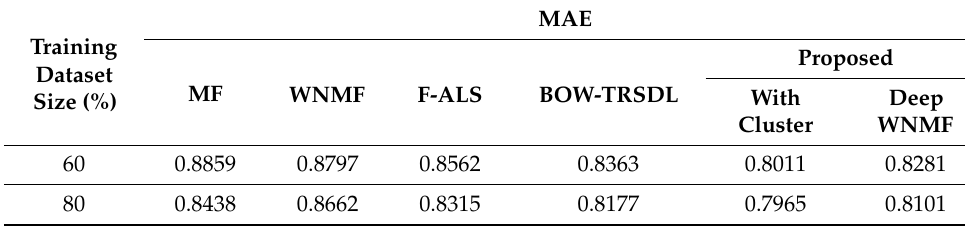
Table 2. The model prediction error with comparisons.